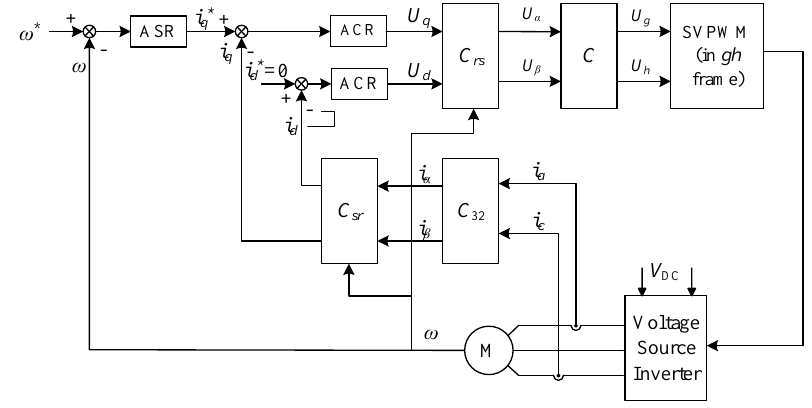
Figure 6. FOC structure of the PMSM in the 60° coordinate system. In Figure 6, the SVPWM algorithm is implemented in a 60° coordinate system. An- other difference between the FOC in the 60° coordinate system and the conventional frame is that the reference currents i g * and i h * and feedback currents i g and i h are the values in the 60° coordinate system (Figure 6). The transformation matrixes C and D are already stated in Section 3. The voltage equations of PMSM in the 60° coordinate system can be derived as fol- lows: